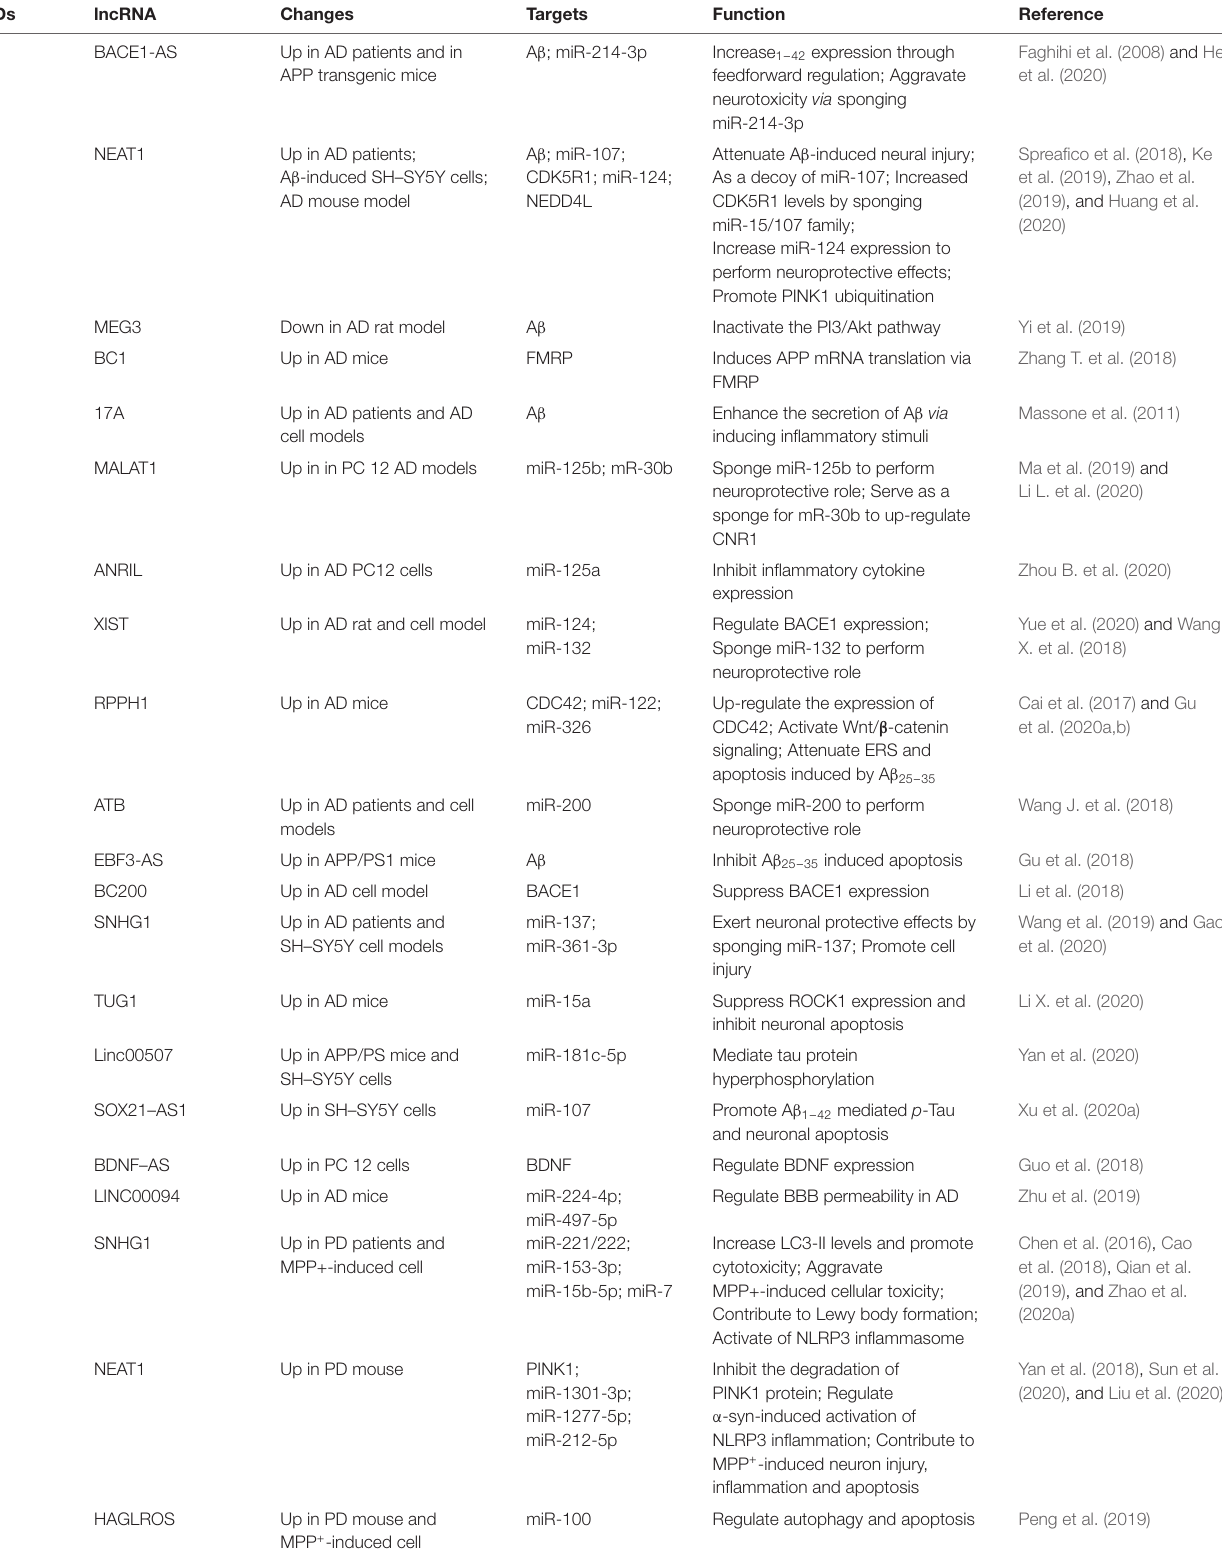
TABLE 1 | Long noncoding RNAs associated with the pathogenesis of neurodegenerative